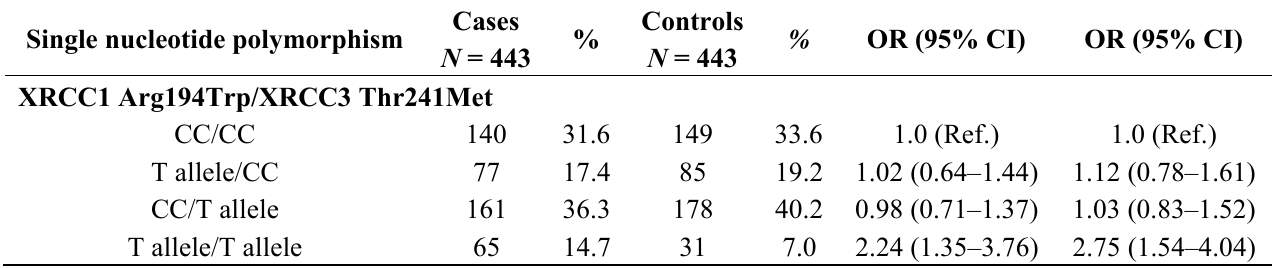
Table 4. Interactions of XRCC1 A194T and XRCC3 C241T in cases and controls on glioma